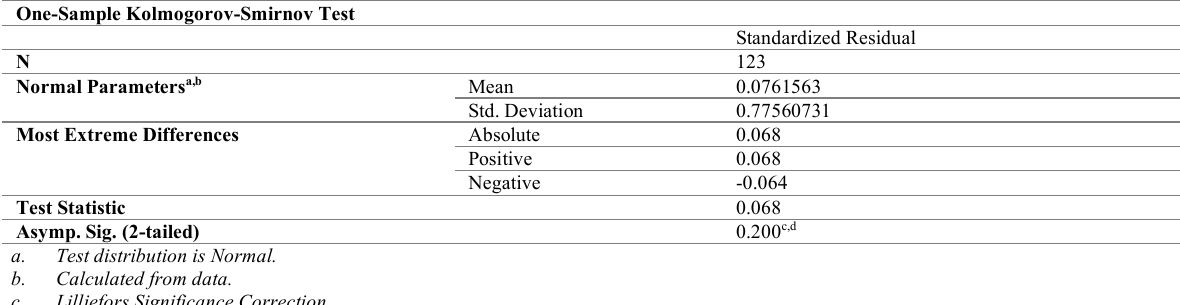
Table 3 : Data Normality Test Results (Work engagement)